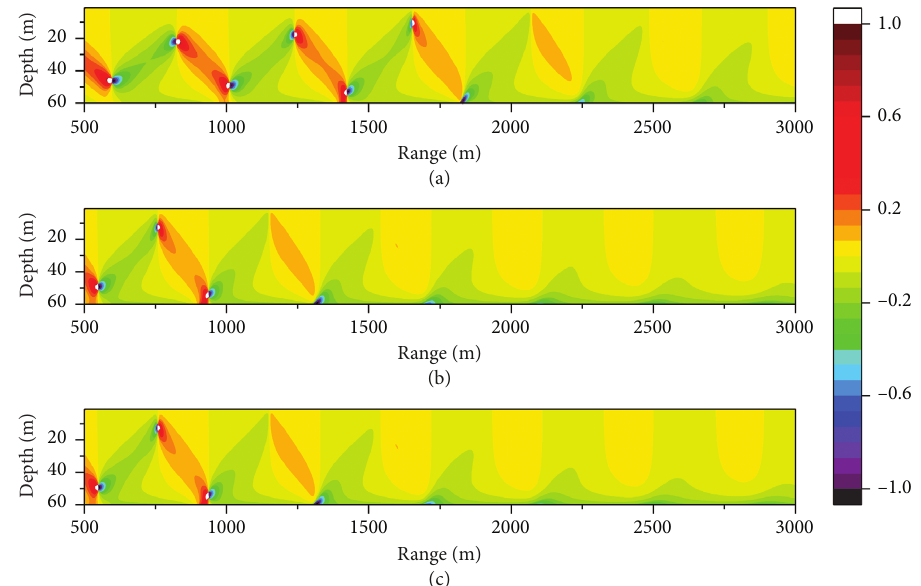
Figure 18: I ∗ � 2000kg/m 3 ; (c) ρ ρ 1